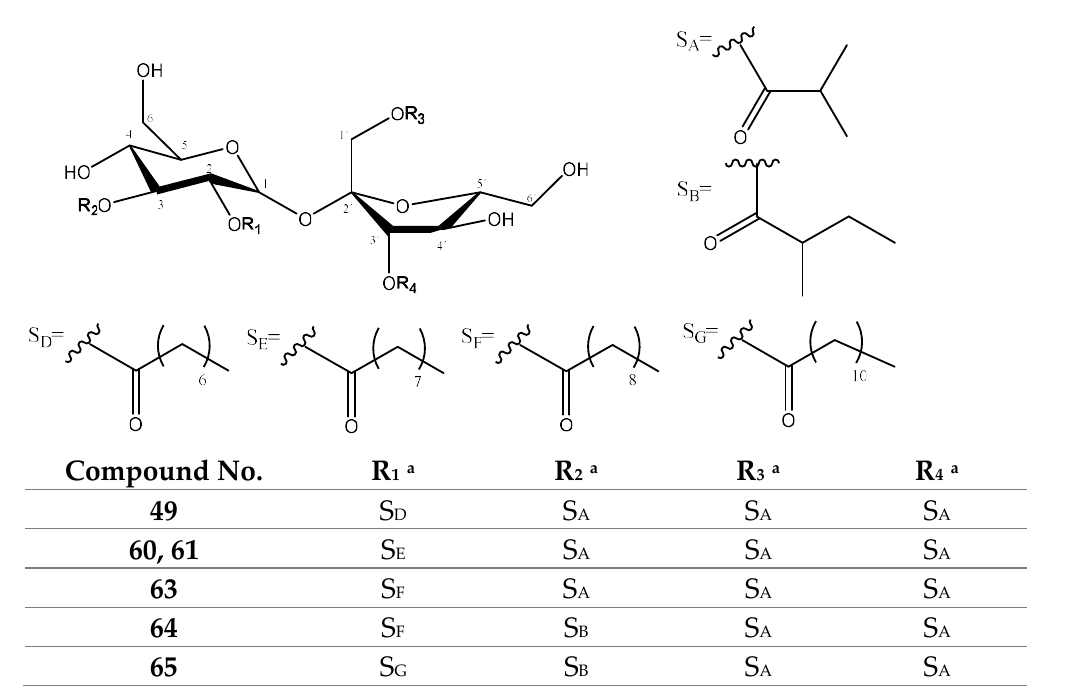
Figure 15. Tetrasubstituted sucrose ester derivatives.